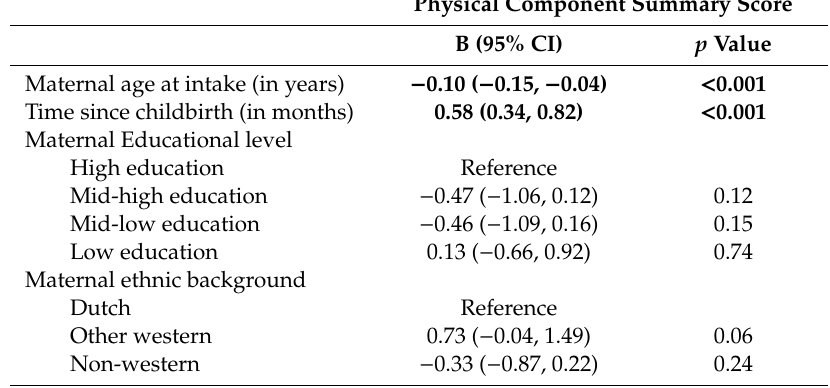
Table 2. Multivariable associations with physical component summary score in the imputed dataset ( n =